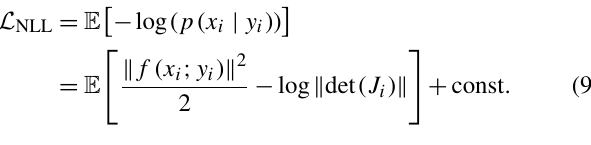
posterior prediction of p x ( x | y ) with the true posterior of the inverse problem (Noever-Castelos et al., 2021).